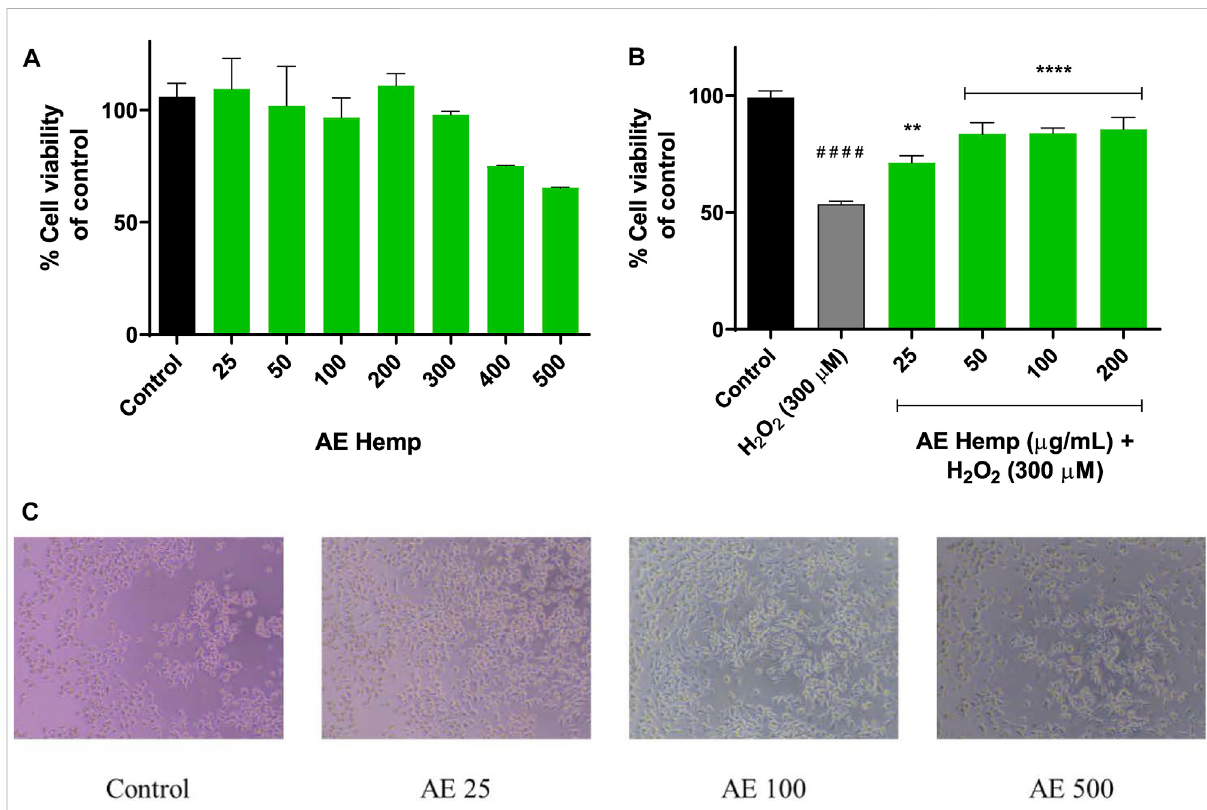
FIGURE 3 Mitochondrial response. (A) Cytotoxicity of Neuro-2a cells after exposure to different concentrations of Cannabis sativa aqueous extract. (B) Cytoprotective effects of Cannabis sativa aqueous extract versus hydrogen peroxide (300 µM). (C) Inverted microscope images of Neuro-2a